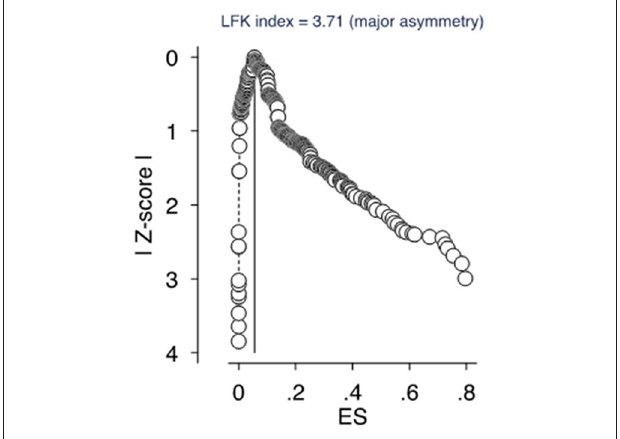
Figure 3 | The DOI plot and the Luis Furuya–Kanamori (LFK)